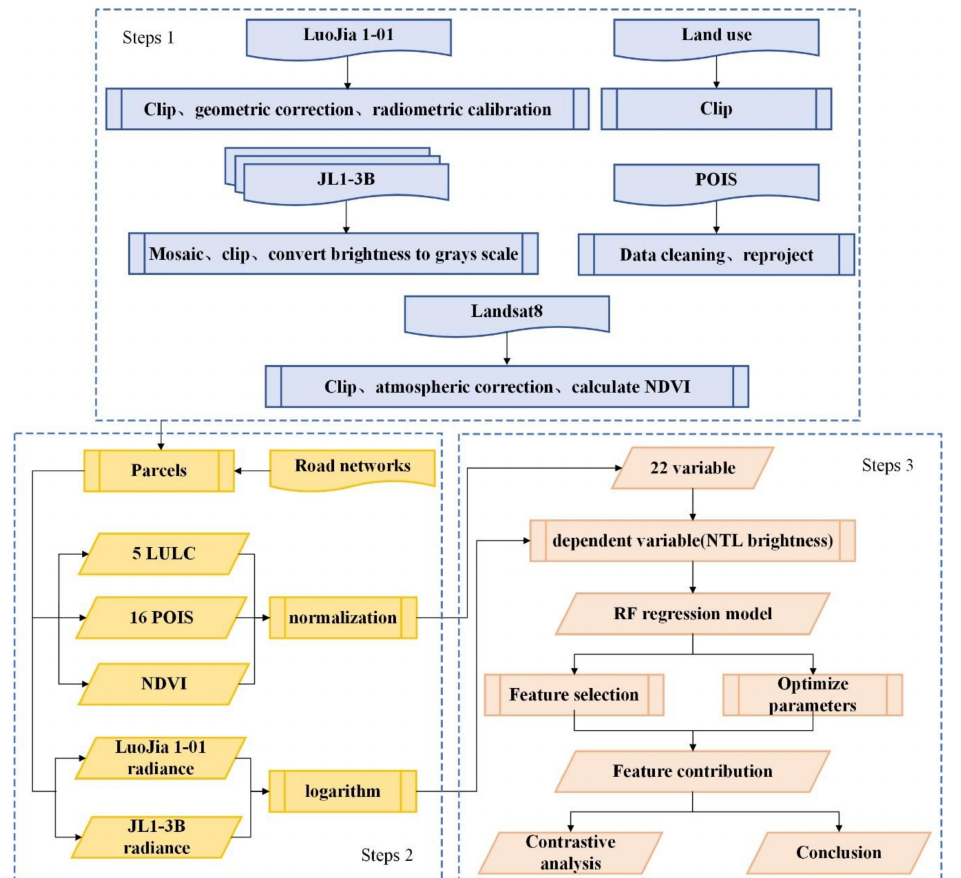
Figure 4. Methodology flowchart. Step 1: data preprocessing; step 2: making parcels datasets; step 3: establishing the random forest (RF) regression model and analyzing the features